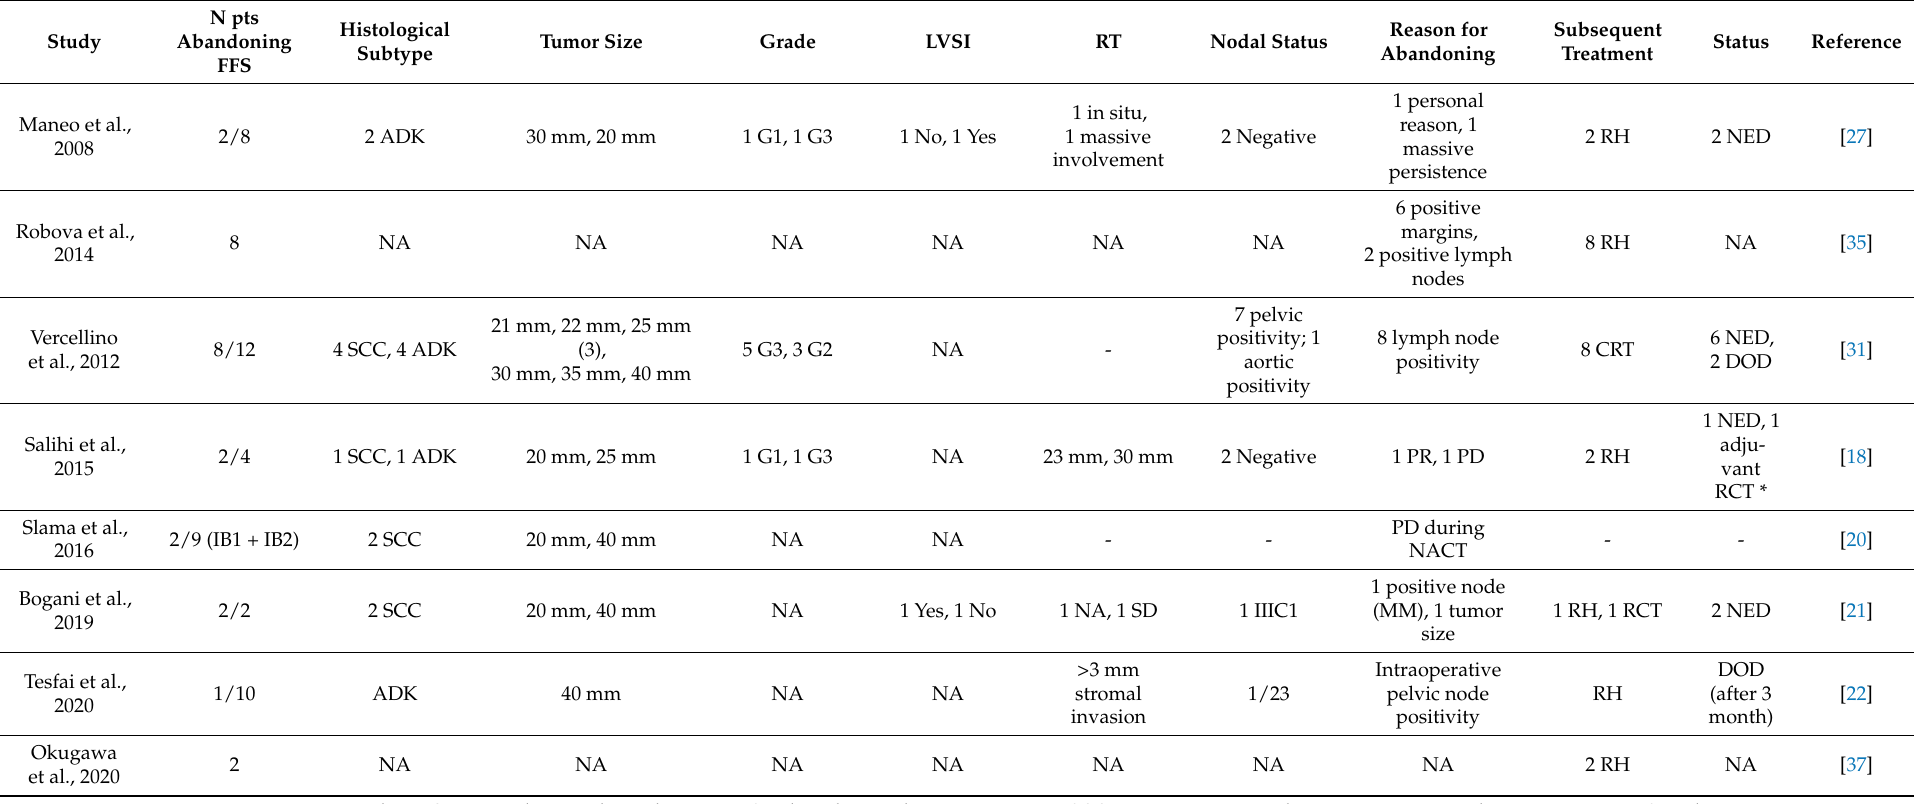
Table 2. Characteristics of patients abandoning the fertility-sparing approach after neoadjuvant